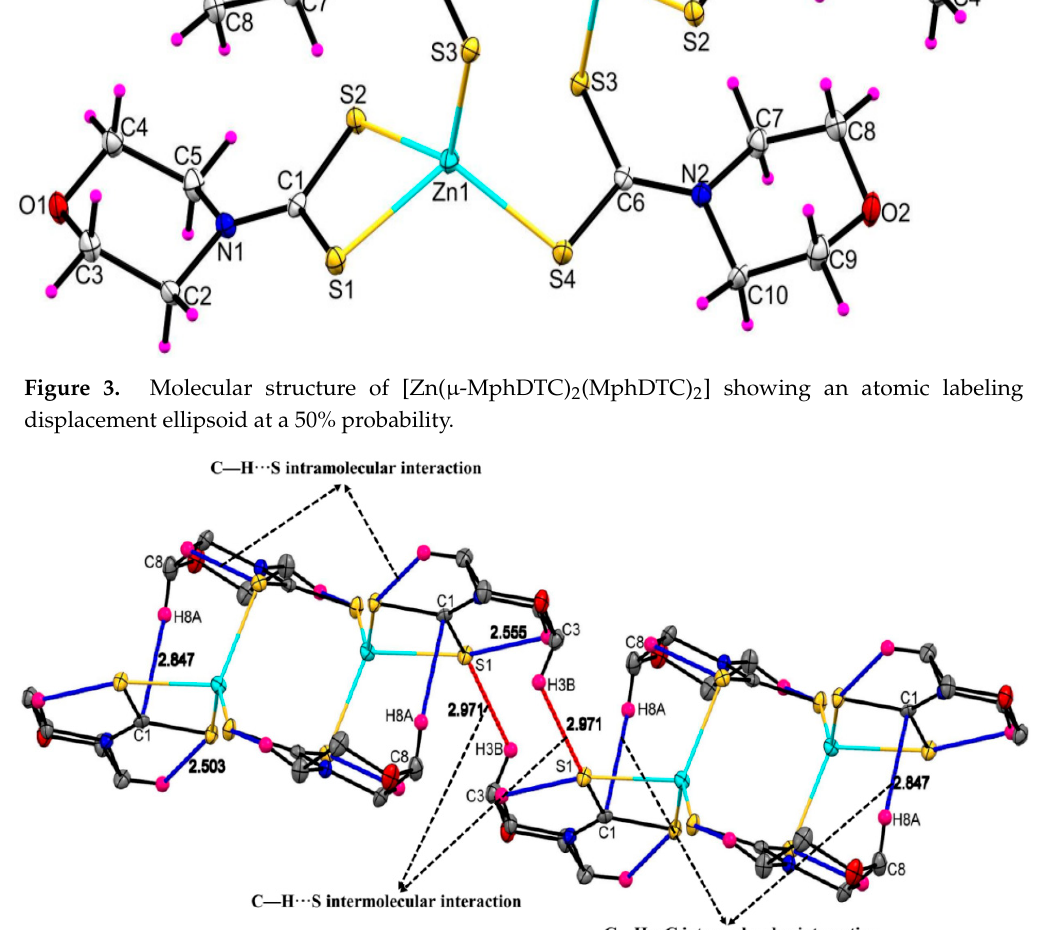
Figure 4. Intramolecular C–H···C, C–H···S (blue dash lines) and intermolecular C–H···S (red dash lines) interactions of [Zn( μ -MphDTC) 2 (MphDTC) 2 ]. Non-interacting hydrogen atoms are omitted for clarity.